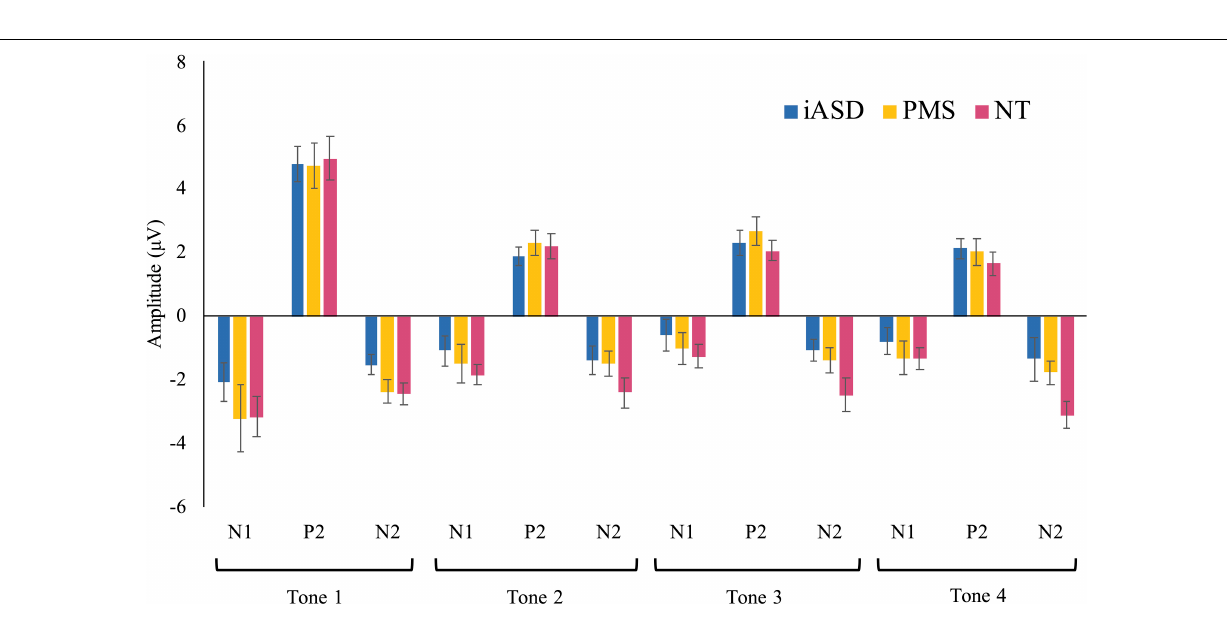
Frontiers in Neuroscience |